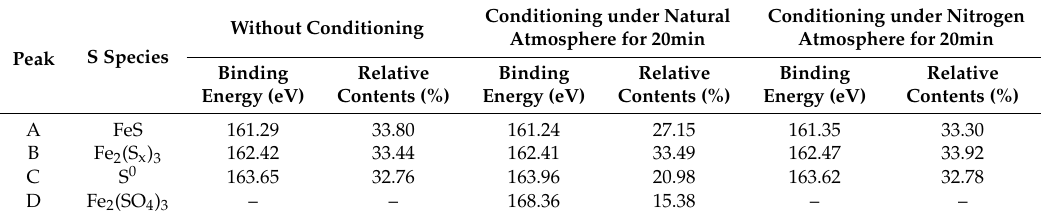
Figure 11. S2p spectra for the pyrrhotite surface treated: ( a ) without conditioning; ( b ) with conditioning under the natural atmosphere for 20 min; and ( c ) with conditioning under the nitrogen atmosphere for 20 min. Table 3. S species binding energy (eV) and relative contents (%) for the pyrrhotite surface treated with different types of conditioning.